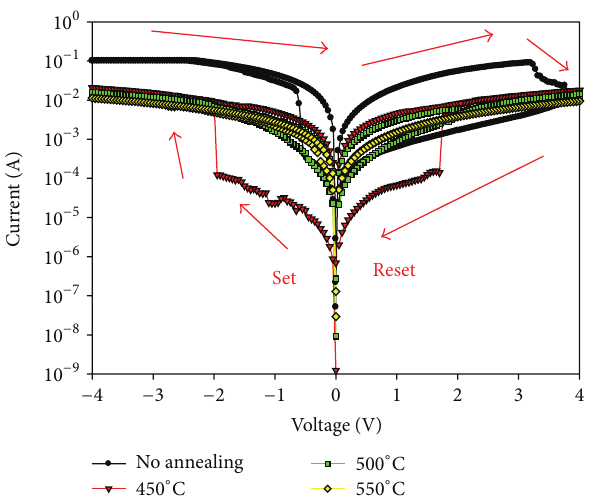
Figure 5: I-V characteristics of the CBTi144 RRAM cell without and with 450–550 ∘ C RTA.